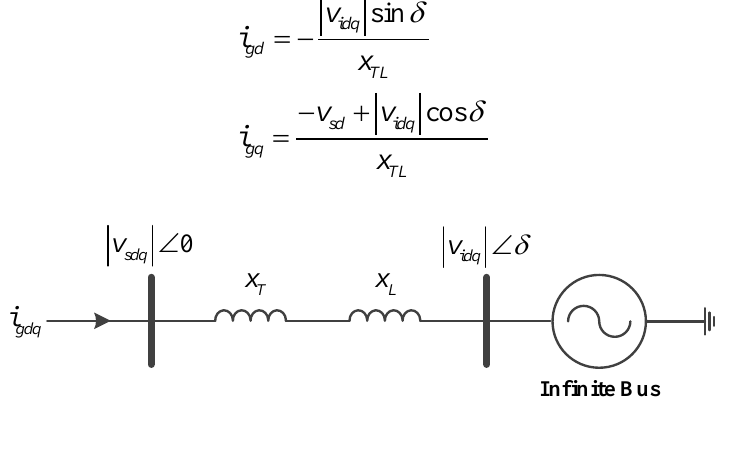
Figure 5. One-line diagram of the power